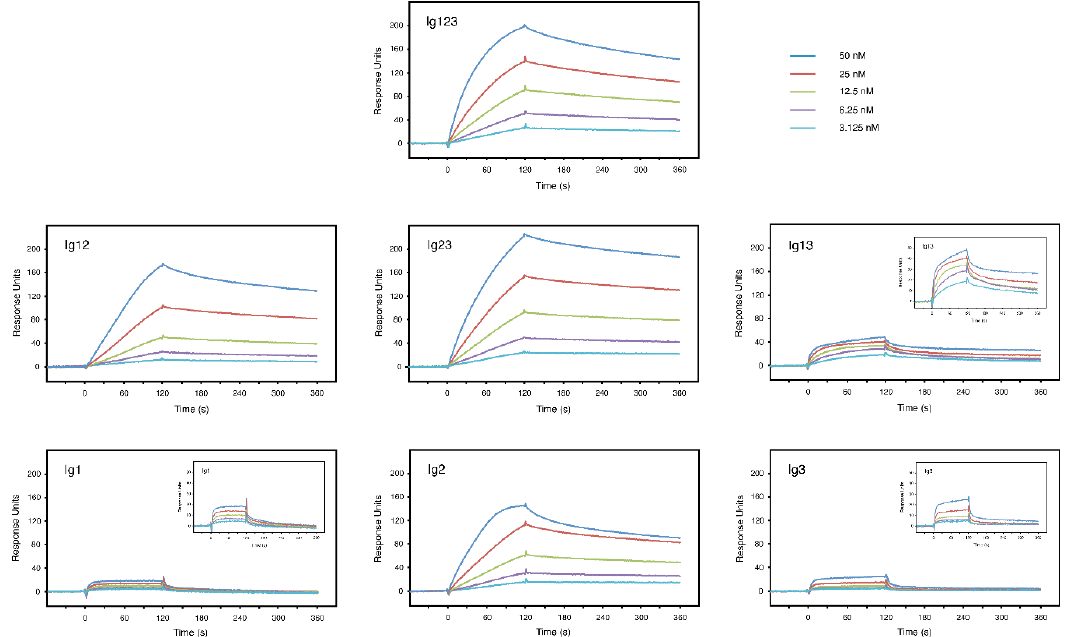
Figure 4. Surface plasmon resonance analysis of FGF8 and different FGFRL1 constructs. A Biacore sensor chip was coated with FGF8 and increasing concentrations of different FGFRL1 polypeptides as indicated were injected over the chip surface. After 120 s, buffer alone was passed over the chip to monitor the dissociation phase. Depending on the individual construct, the assay was performed 2–6 times yielding very similar results and the panels show one representative example of each measurement. In order to visualize low affinity interactions, small insets are displayed, in which the range of the y -axis was enlarged (0–50 RU). Note that Ig123, Ig12, Ig23 and Ig2 bind with high affinity to FGF8 immobilized on the chip, whereas all of the other constructs show dramatically lower binding responses. The different concentrations were: Blue 50 nM, red 25 nM, green 12.5 nM, purple 6.25 nM, light blue 3.125 nM.